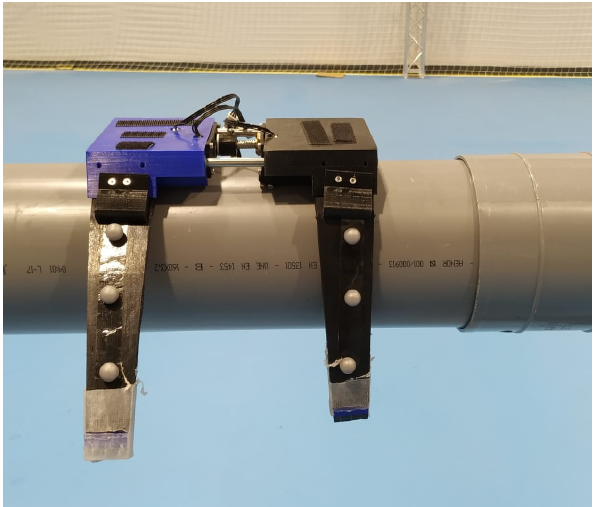
Figure 13. Placement of markers on a pair of soft